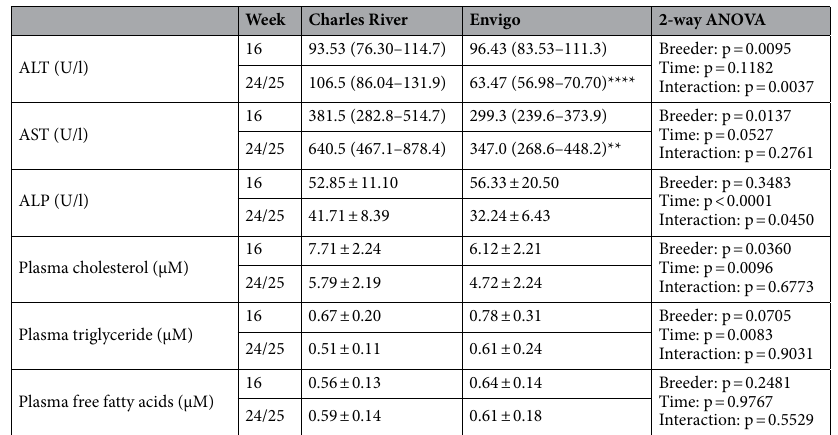
Table 1. Liver enzymes and plasma lipids in high fat fed guinea pigs with NASH. Means with standard deviations or geometic means with 95% confidence intervals. n Charles River week 16 = 13, n Envigo week 16 = 7–8, n Charles River week 24/25 = 17, n Envigo week 24/25= 29–30. ALP at week 16 n = 3 for Envigo only. ALP alkaline phosphatase , ALT alanine aminotransferase, AST aspartate aminotransferase. **p < 0.01 ****p < 0.0001 vs Charles River at same time point. Analysed by two-way ANOVA with Sidak’s multiple comparison test.